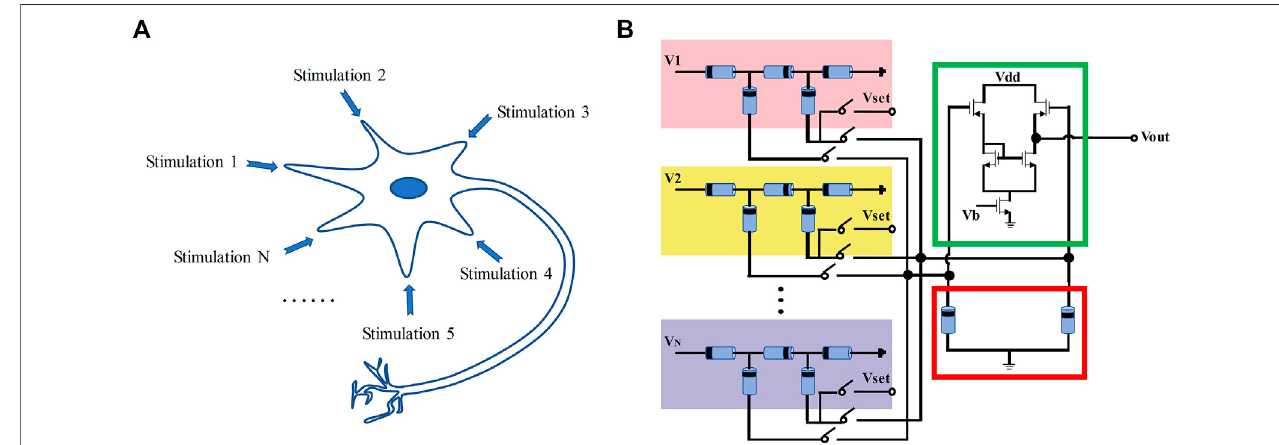
FIGURE 6 | Comparison of neuronal biological schematics with the proposed neuron structure. (A) Neuronal biological schematics. (B) Structural diagram of a neuronal circuit composed of the π -type synaptic structure.